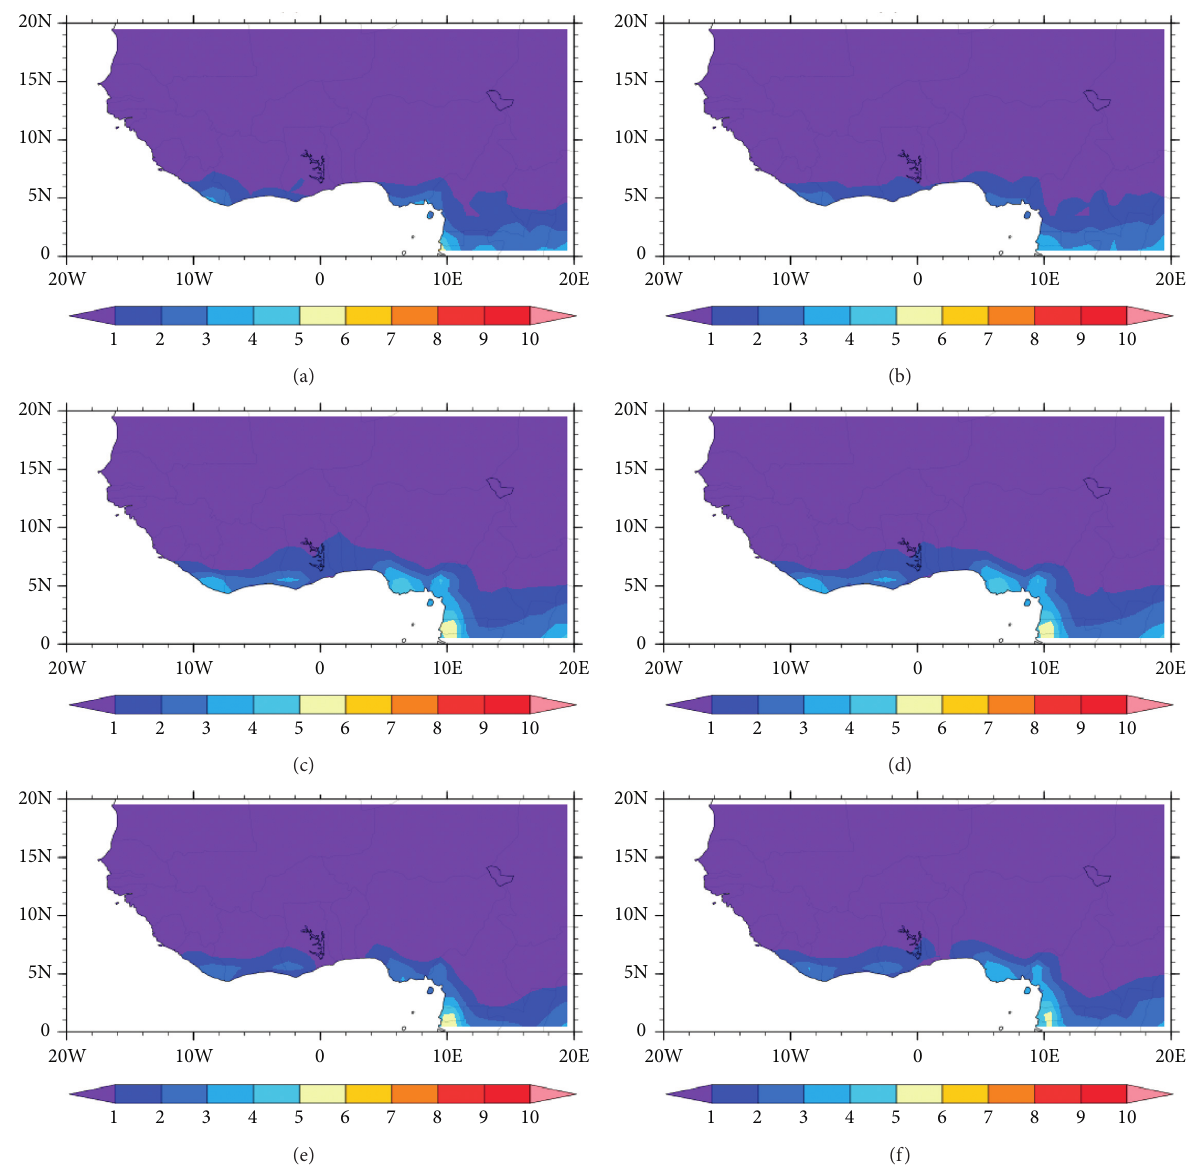
Figure 9: Spatial distribution of average precipitation for Dec 16 th 2011–Feb 28 th , 2012. (a) TRMM. (b) GPCP. (c) Noah-MP groundwater option-ERA. (d) Noah-MP. (e) Noah. (f) CLM4.